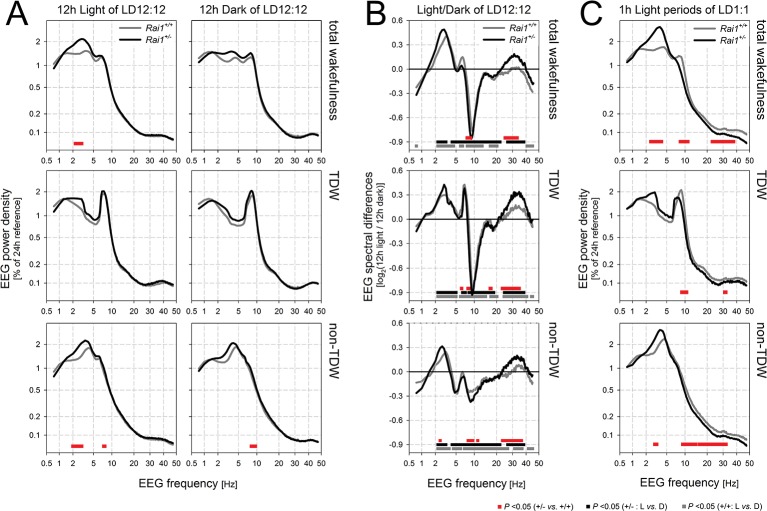
Spectral analysis of the waking EEG of Rai1+/- mice show an increased activity within the high delta band.(A) Mean waking EEG spectra during total wakefulness (top), theta dominated wakefulness (TDW; middle), and the remaining wakefulness (non-TDW; lower panels) under the 12 hr light (left) and 12 hr dark (right panels) portion of two baseline days. Rai1+/-: black lines and symbols (n = 7); Rai1+/+: grey lines and symbols (n = 8). Red bars; p<0.05; t-tests. While the TDW EEG did not differ, in non-TDW (‘quiet’ waking) power density in the 2–3 Hz range was increased in Rai1+/- mice. (B) EEG spectral light/dark ratios for total wakefulness (top), TDW (middle), and non-TDW (lower panels). Zero levels in each panel represent the EEG activity during the 12 hr dark periods. Both genotypes show light-dark differences in EEG spectral profiles over a large frequency range (Rai1+/-: black bars; Rai1+/+: grey bars; p<0.05; t-tests). These light-dark differences were modulated by genotype only within the high-delta band and for frequencies between 25–40 Hz (red bars; p<0.05; t-tests). Note that both the prominent downward deflection, maximal close to 10 Hz, and the smaller upward deflection, peaking at around 7 Hz, observed in both genotypes are entirely due to a ~ 0.75 Hz faster TDW theta peak frequency in the dark compared to the light period. (C) The analysis under (A) was repeated for the 24 1h-light pulses under the 48 hr LD1:1 protocol. Again, non-TDW EEG activity in 2–3 Hz range increased when Rai1+/- mice were exposed to light arguing against circadian factors contributing to the results under (A).